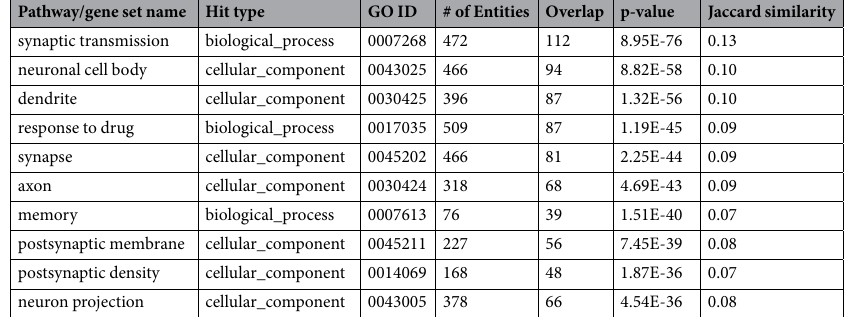
Table 1. Top 20 Molecular function pathways/groups enriched by 535 reported genes. Note: For each gene set, the p-value was calculated using Fisher-Exact test against the hypothesis that a randomly selected gene group of the same size (535) would generate the same or higher overlap with a given gene set (q = 0.001 for FDR correction). Jaccard similarity ( J s ) is a statistic used for comparing the similarity and diversity of sample sets, , where A and B are two sample which is defined by = ∩ J A B ( , ) s A B ∪ A B